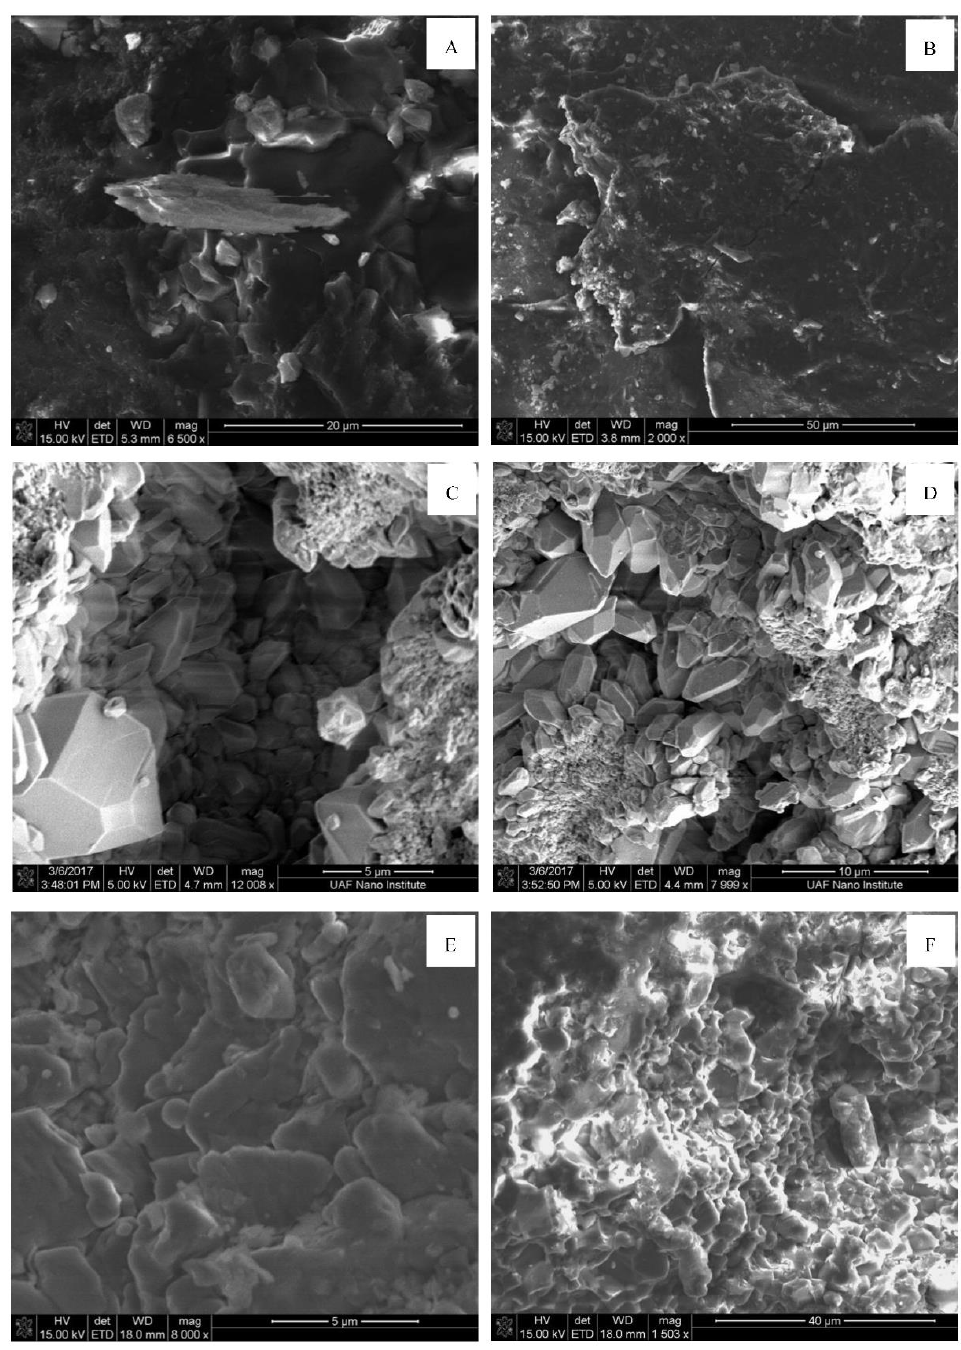
Figure 4. Scanning electron microscope secondary electron (SEM-SE) images of dolomite from the Cotter Dolomite ( A , B ), quartz from the tripolitic chert of the Boone Formation ( C , D ), and quartz from the Bigfork Chert ( E , F ). Late diagenetic dolostones exhibit porosities and permeabilities significantly greater than those of early diagenetic replacement dolostones [37]. Late diagenetic dolomitization of the Knox was related to secondary porosity development, hydrocarbon migration, and local MVT mineralization [37]. In a similar way, dolomitization of the carbonate facies that host mineralization in the Upper Cambrian Bonneterre Dolomite in the Southeastern Missouri MVT district was of early diagenetic origin, and later underwent neomorphic recrystallization and cementation during exposure to mineralizing fluids [38–40]. Central and East Tennessee MVT ores, and part of Northern Arkansas MVT ores, are